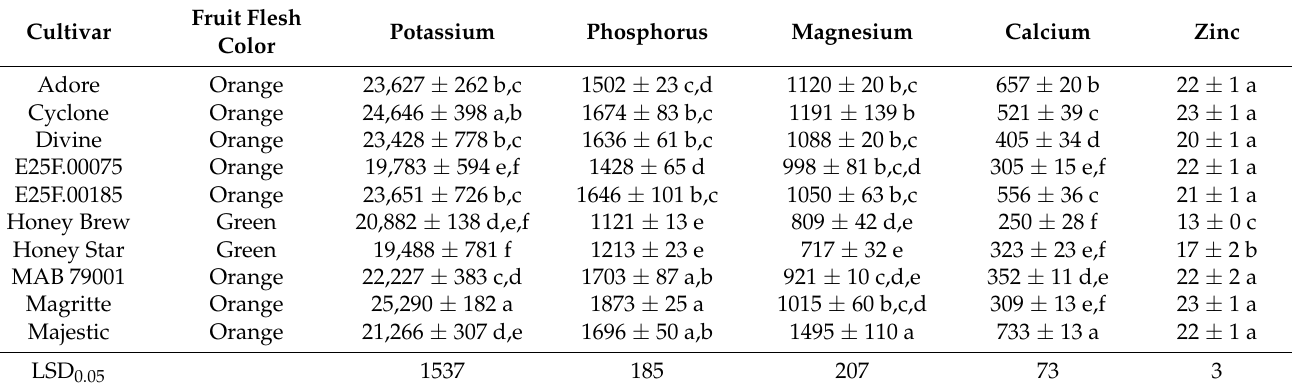
Table 1. Sweet melon fruit mineral element content (mg kg − 1 dry weight) at